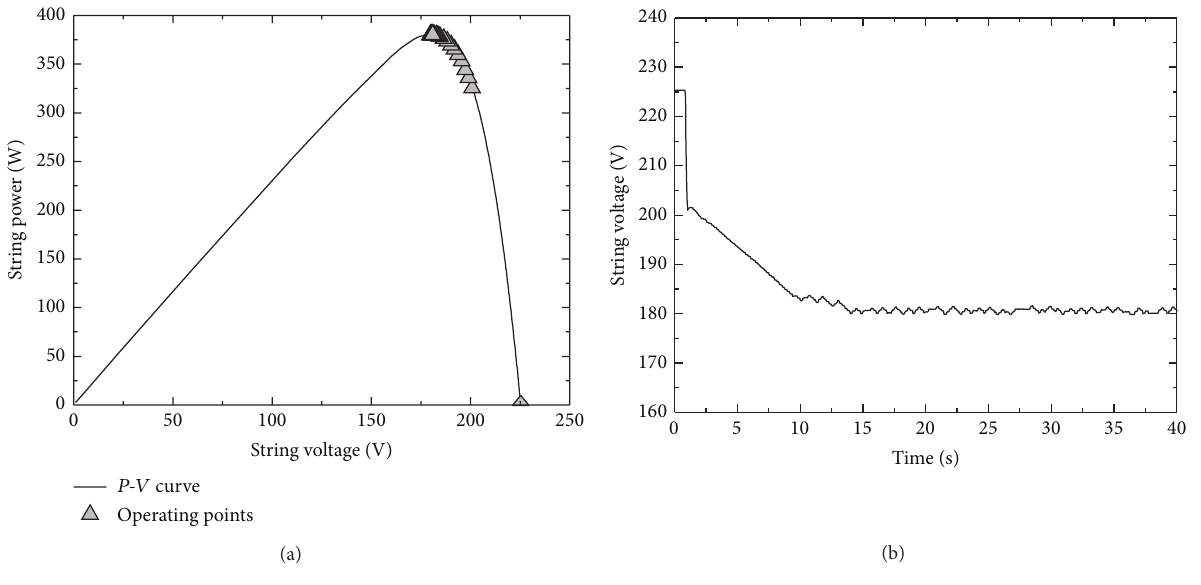
Figure 10: Sunny case. (a) Experimental power-voltage characteristic (solid line) of the 10-panel test string under full irradiation. The operating points of the string (triangles) by adopting a classic P&O algorithm are shown. (b) String power against the time.